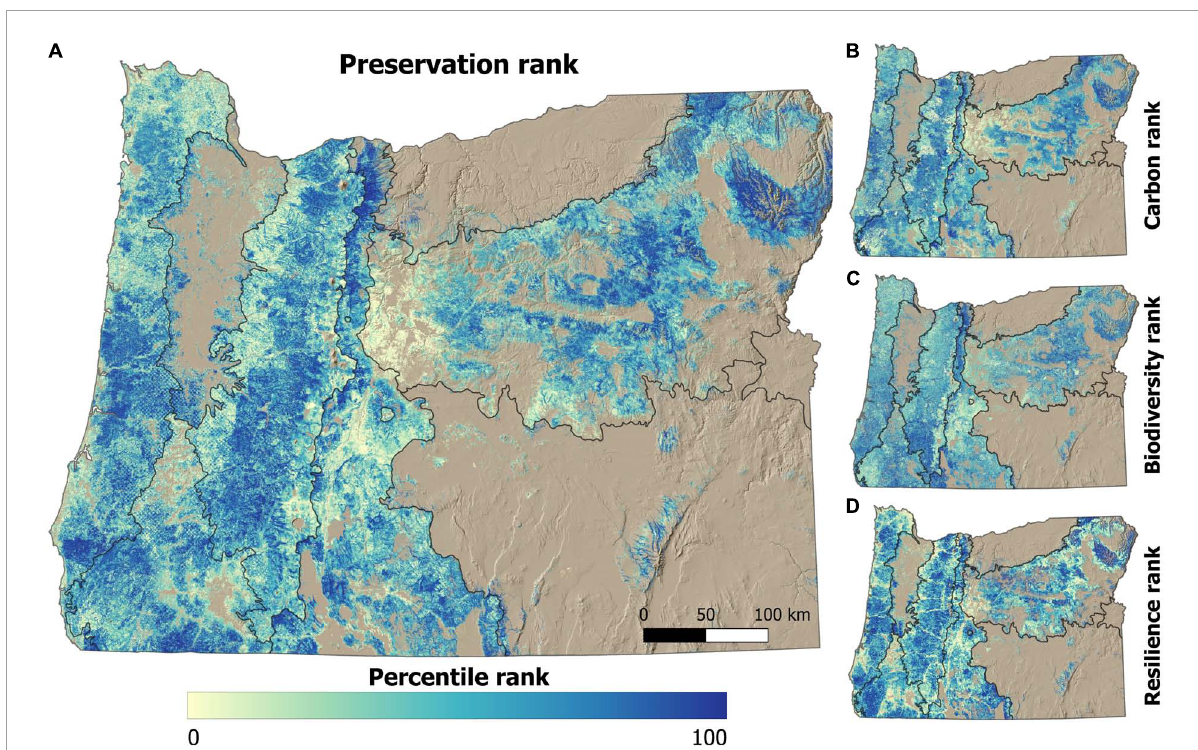
FIGURE2 Oregon forest preservation, carbon, biodiversity, and climate resilience priority rankings. (A) Forest preservation priority ranks were derived from (B) carbon, (C) biodiversity, and (D) climate resilience priority ranks within each ecoregion. Forest carbon ranks were based on tree aboveground carbon stocks (AGC) stocks. Forest biodiversity ranks incorporate species richness of amphibians, birds, mammals, reptiles, and trees. Climate resilience priority ranks incorporated topoclimatic diversity and landscape connectivity.